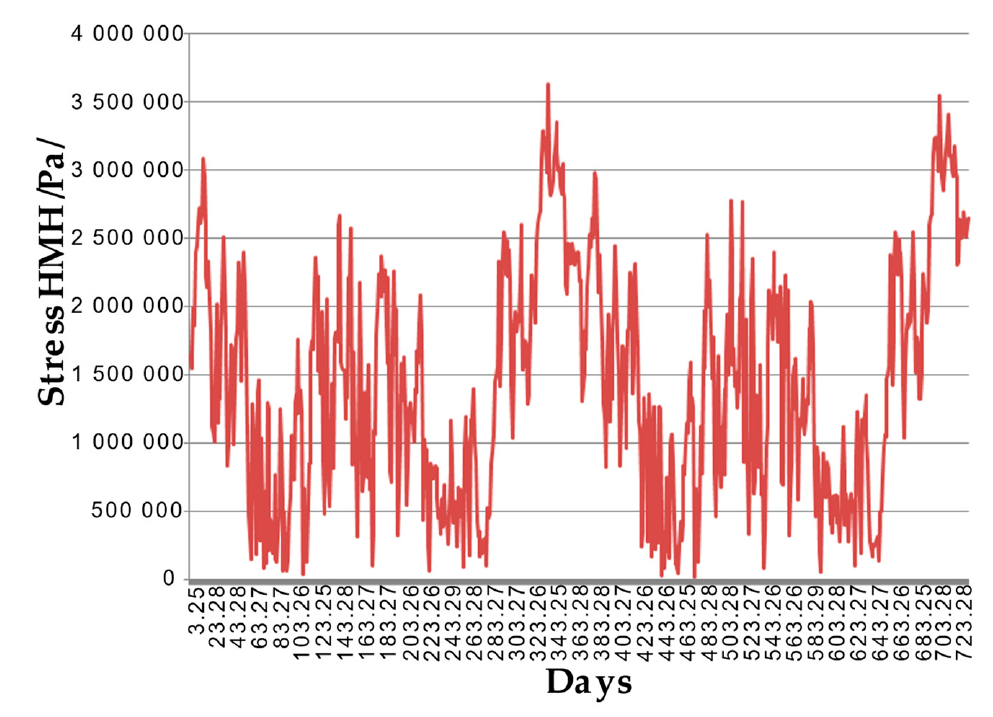
Figure 9. Plot of time dependence of the von Mises equivalent stress (HMH) /Pa/ at a depth of 2812.5 m between sections 1 and 2 of Figure 3 ( φ = 0°).